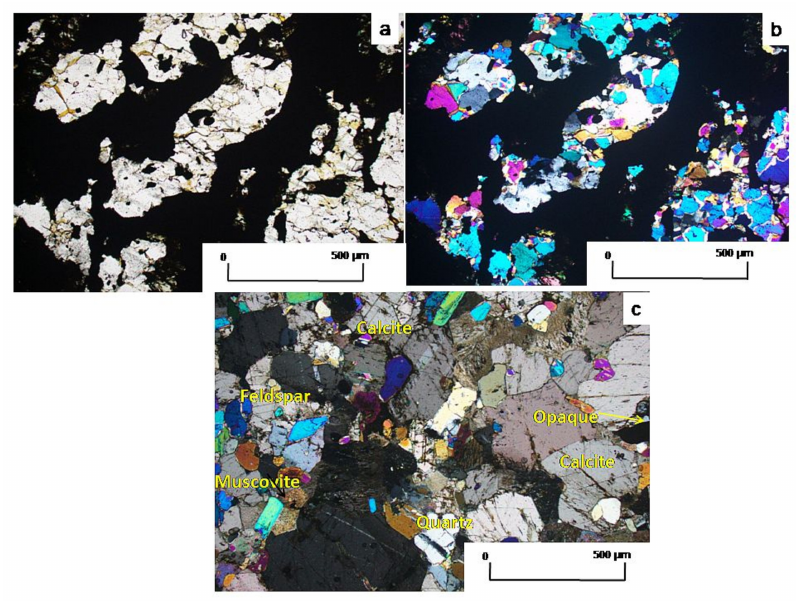
Figure 5. ( a ) Plain-polarized optical thin section of banded magnetite quartzite (BMQ) under micro- scope. ( b ) Cross-polarized optical thin section of BMQ. In this thin section, magnetite appears dark. ( c ) Cross-polarized optical thin section of calcareous silicate